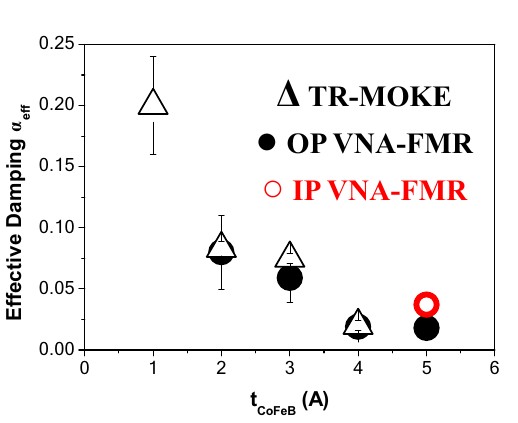
Figure 6. Evolution of the effective damping ( α eff ) versus t CoFeB and determined from the TR-MOKE measurements (black open triangle), the perpendicular VNA-FMR (black filled circle) and the in-plane VNA- FMR (red open circle)